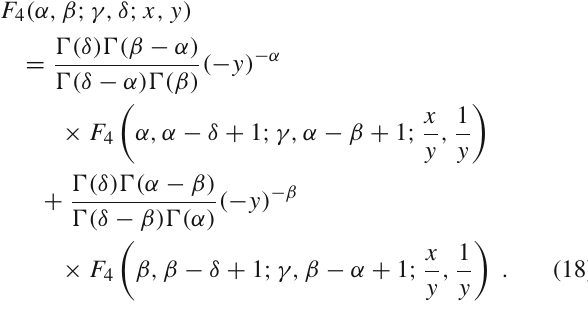
3 New analytic continuations for the Lauricella F